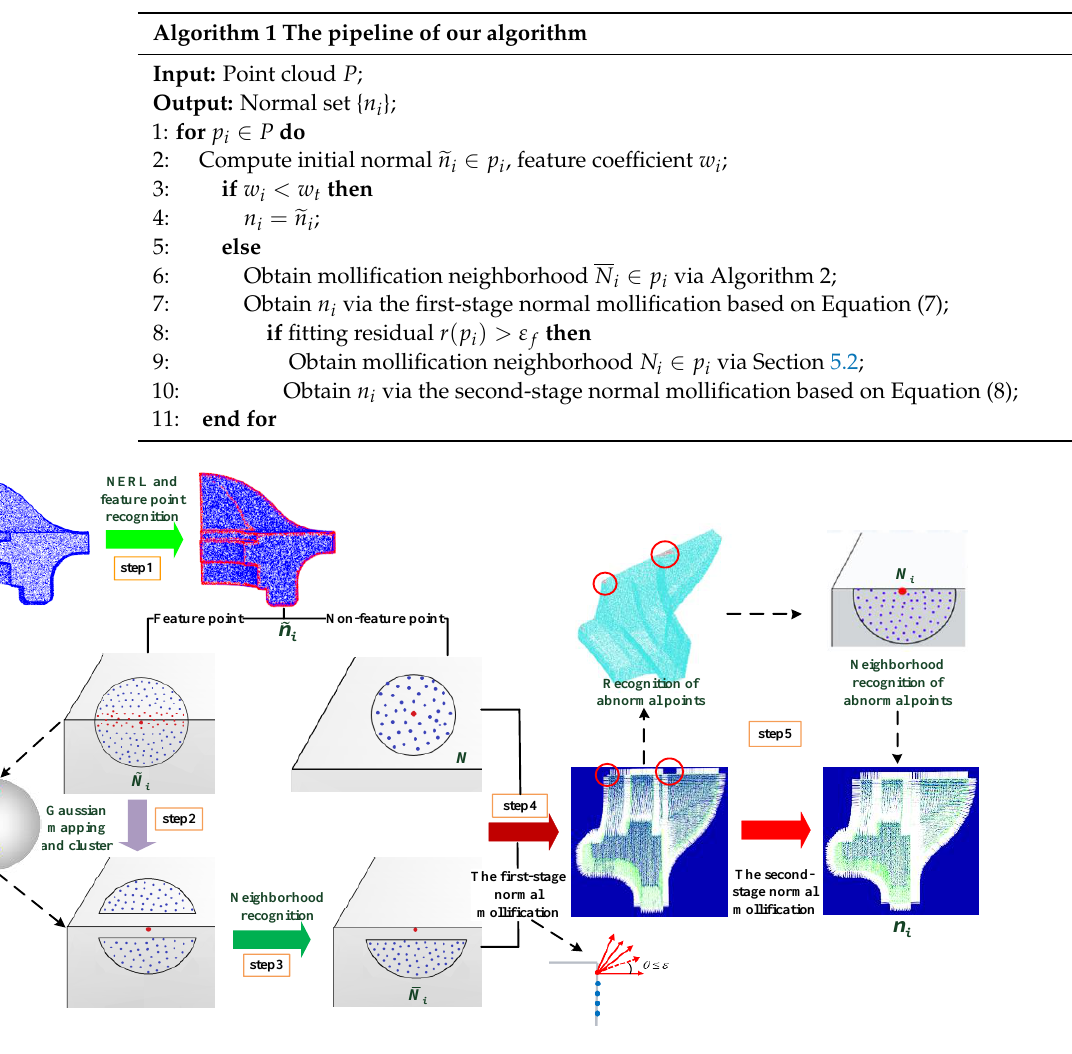
Figure 1. The pipeline of our algorithm ( N represents the neighborhood of each stage, and n denotes the normal of the stage).